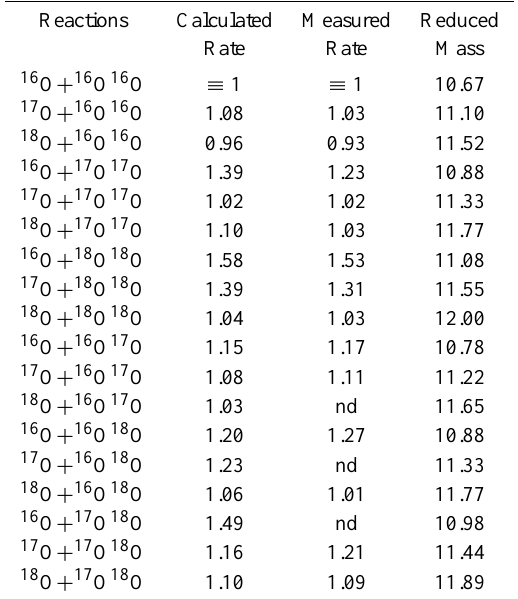
Table 3. Isotopomer specific rate coefficients calculated with the parameters defined in the appendix and having the values β = 1 .